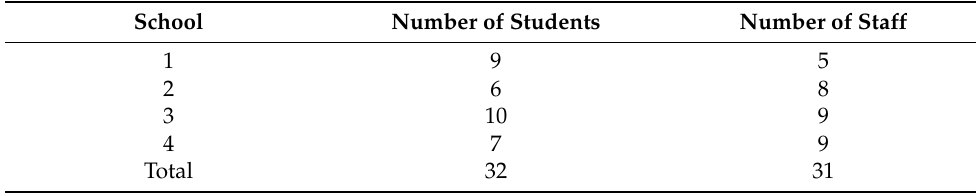
Table 1. Breakdown of study participants across